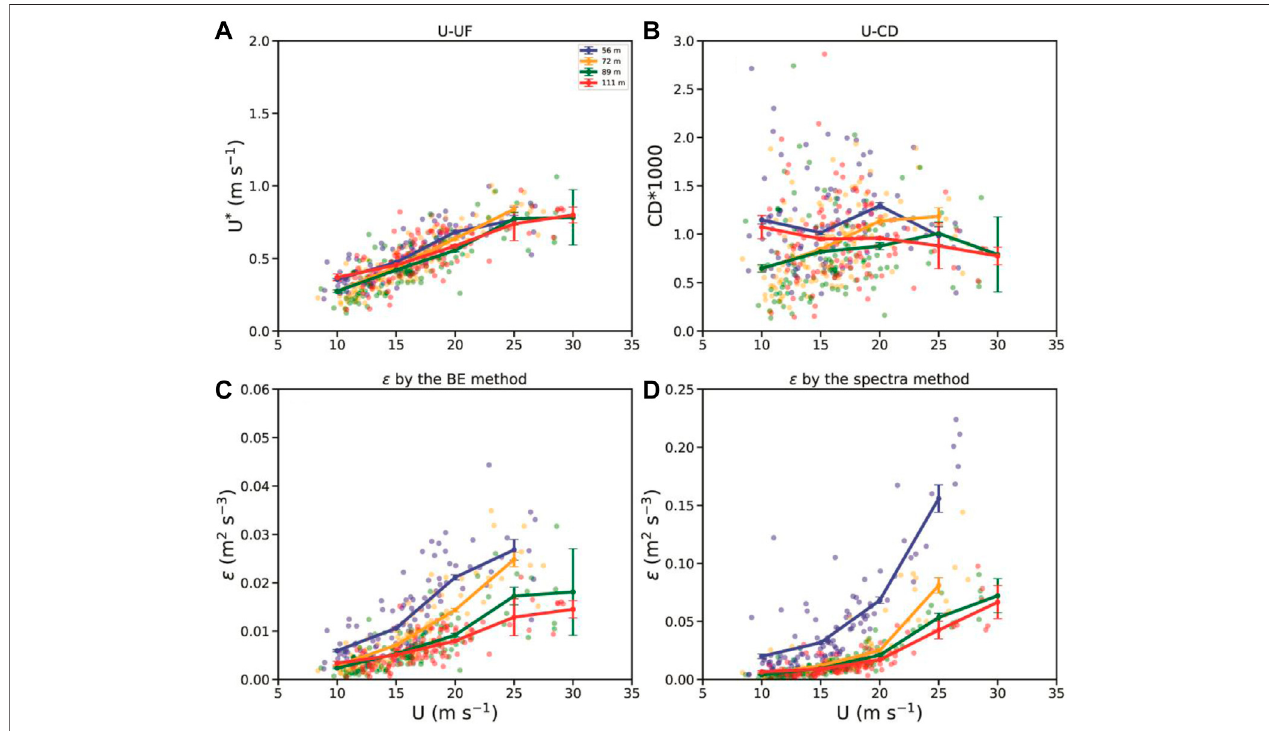
FIGURE 5 | Plots of (A) the friction velocity, (B) drag coef fi cients, and (C) dissipative rates estimated with the BE method and (D) turbulent spectra method as a function of the mean wind speed. The blue, orange, green, and red solid lines with error bars indicate the bin-averaged values of the two variables at z = 56, 72, 89, and 111 m, respectively. The error bars represent the 95% con fi dence